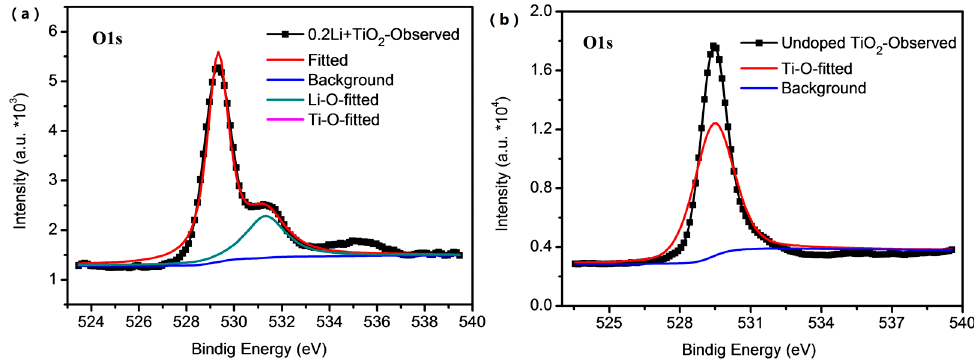
Figure 1. X-ray photoelectron spectroscopy. ( a ) The O1s peaks fitting for 0.2Li + TiO 2 sample. ( b ) The O1s peak fitting for undoped TiO 2 sample.